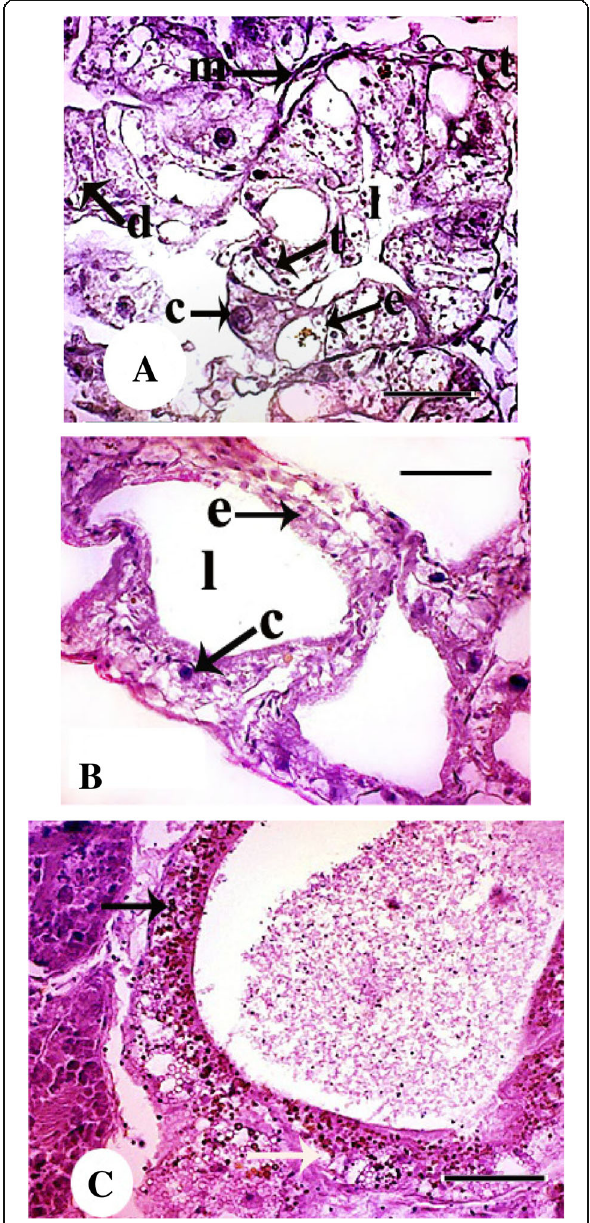
Fig. 5 A Photomicrograph of digestive gland of unexposed snails showing the digestive tubules surrounded by circular muscle fibers (m), separated from each other by connective tissue (ct); each tubule have a central lumen (l) which is surrounded with calcium cells (c), excretory cells (e), digestive cells (d), and thin cells (t). B Photomicrograph of digestive gland of snails exposed to UV-A radiation for 3 h for two successive days shows cuboidal epithelial cell (e), calcium cell (c), and lumen (l). C Photomicrograph of digestive gland of snails exposed to UV-A radiation for 3 h for three successive days showing digestive tubules with many vacuoles (white arrow) and darkly stained granules (black